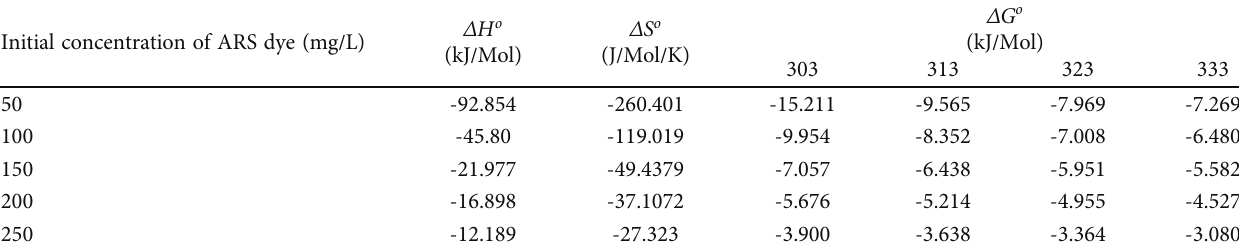
Table 2: Thermodynamic parameters for the adsorption of ARS dye onto the CTASP. Initial concentration of ARS dye (mg/L)